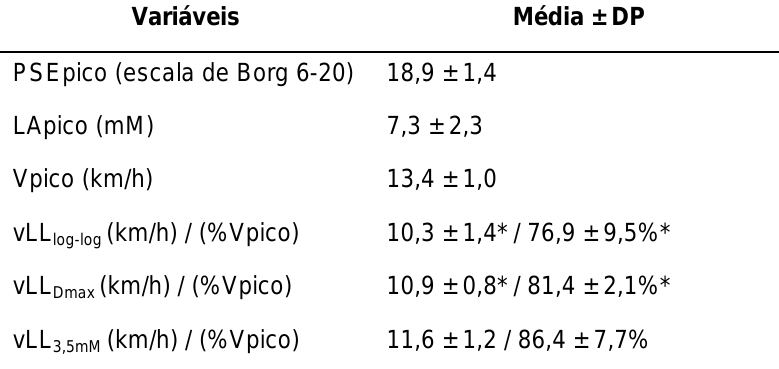
) e log-log (vLL ). Á esquerda, a correlação foi r = Dmax log-log